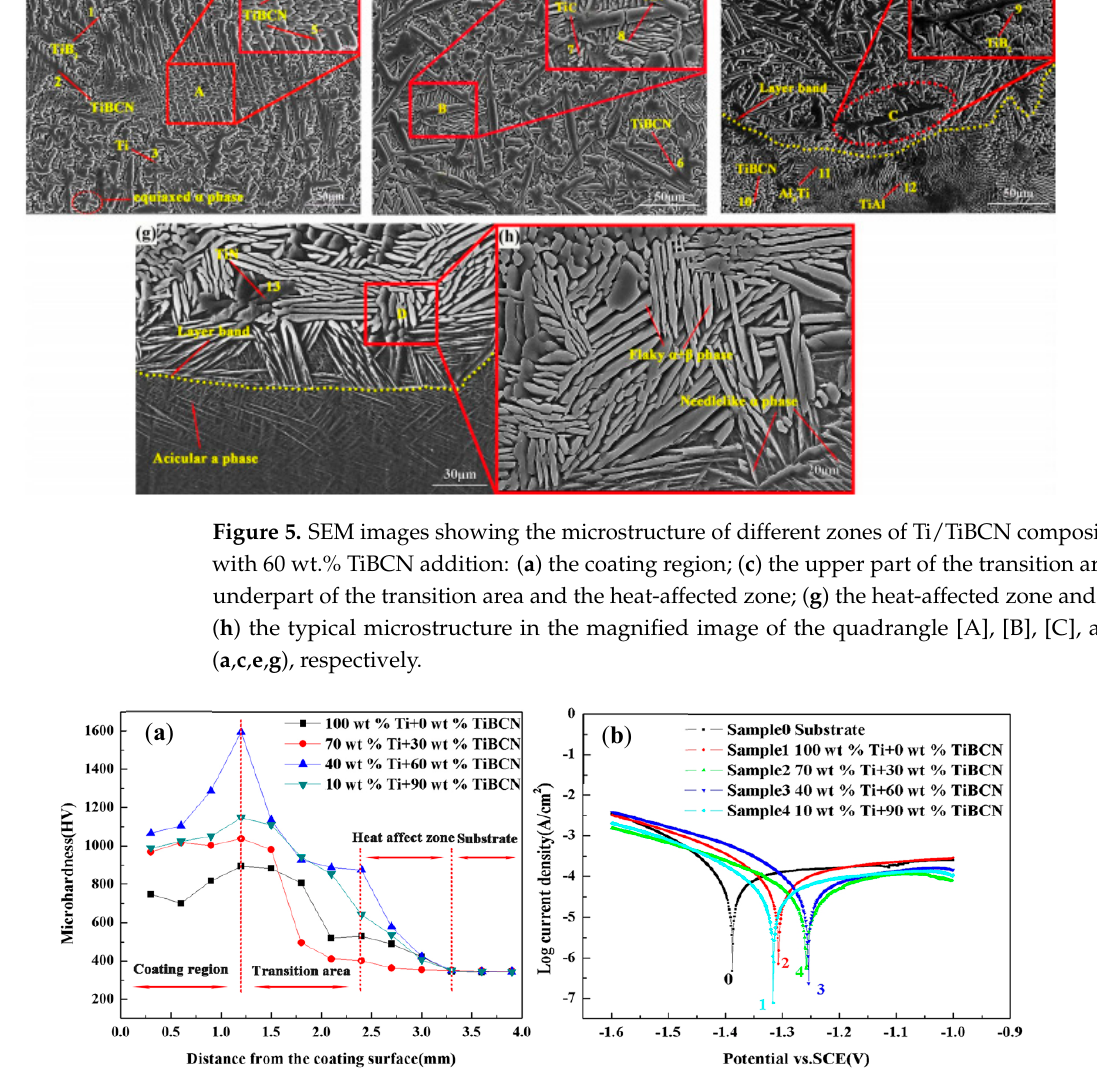
Figure 7. Friction coefficient of the substrate and Ti/TiBCN composite coatings with the different TiBCN contents. Figure 8. Wear mass loss of the substrate and Ti/TiBCN composite coatings with the different TiBCN contents. The research results show that metal-ceramic cladding materials not only improve the bonding ability between ceramic particles and metal substrates but also play an im- portant role in improving the wear resistance, corrosion resistance, and high-temperature oxidation resistance of the metal substrate. Metal-ceramic materials have great develop- ment potential and application space in laser cladding manufacturing. However, the splendid microstructure and properties of the composite coatings are closely related to